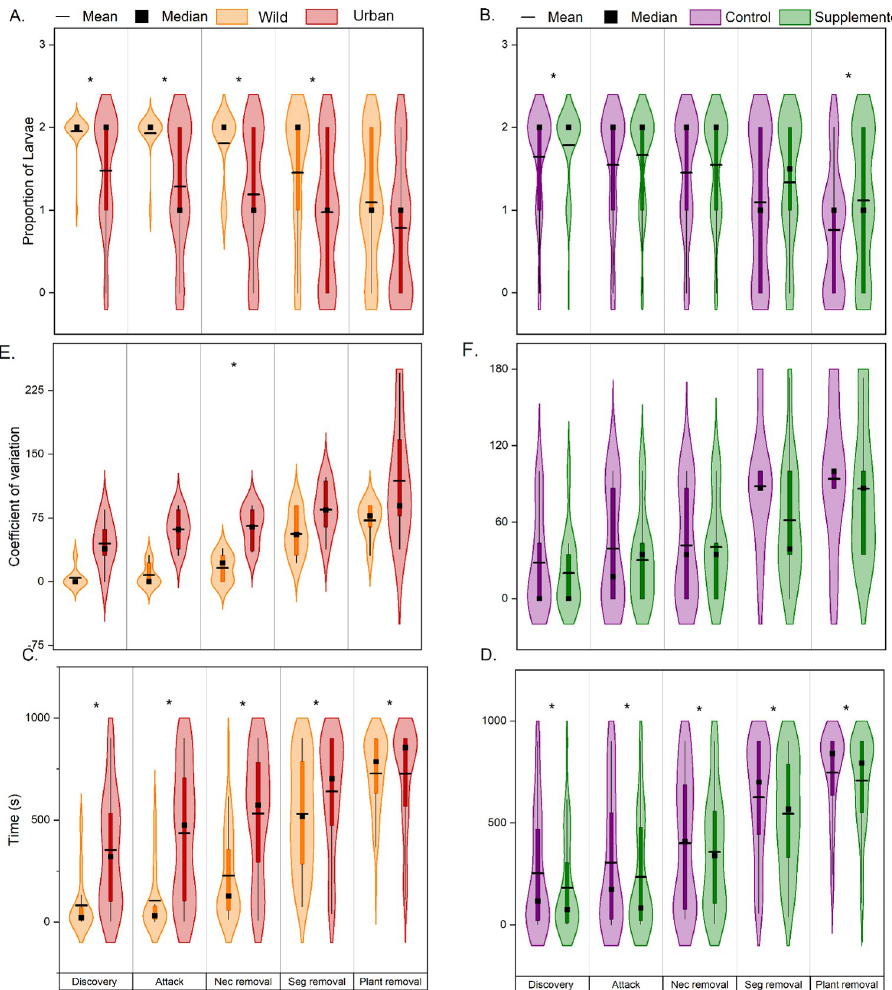
Fig 3. Variation in ant behaviors across sites with different levels of urbanization (left panels) and nectar supplements vs . control plants (right panels). (A, B) The number of D . melanogaster proxy prey that ants discovered, attacked, or removed (from nectaries, segments, and whole plants); (C, D) the relative time it took ants to perform these behaviors; (E, F) the CV for number of proxy prey that were subject to each behavior. Violin plots are as described in Fig 1C. Factors with asterisks were significantly different according to the relative statistical test (P < 0.05). discover proxy prey in wildland sites than in urban sites (Fig 3A; Table 1; ANCOVA: F = ST = 0.0014) and 8% more likely to discover proxy prey on supplemented plants than 14.46, P ST on control plants (Fig 3B, Table 1, ANCOVA: F = 6.37, P = 0.0138). Site type and ant TRT TRT species significantly affected the proportion of proxy prey that ants attacked. Ants in wildland sites were ~33% more likely to attack proxy prey than in urban sites (Fig 3A, ANCOVA, F = ST 11.37, P = 0.0025). While significant, ant species identity had a lower effect size than that of ST site type (ANCOVA, F = 1.83, P = 0.0284). Site type was the only factor that significantly TRT AS affected the proportion of proxy prey that ants removed from nectaries, and desert ants were ~34% more likely to remove proxy prey from nectaries (Fig 3A, ANCOVA, F = 8.38 P = ST ST 0.0059). Again, site type was the only factor that significantly affected the proportion of proxy prey that ants removed from segments; ants were 33% more likely to remove proxy prey from segments in desert sites (Fig 3A, ANCOVA: F = 4.38, P = 0.0378). Unlike previous ST ST